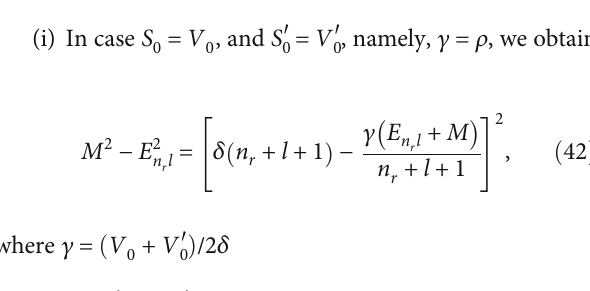
= 0 : 02 , V ′ = 0 : 06 , S = 0 : 035 , and S ′ 0 0 0